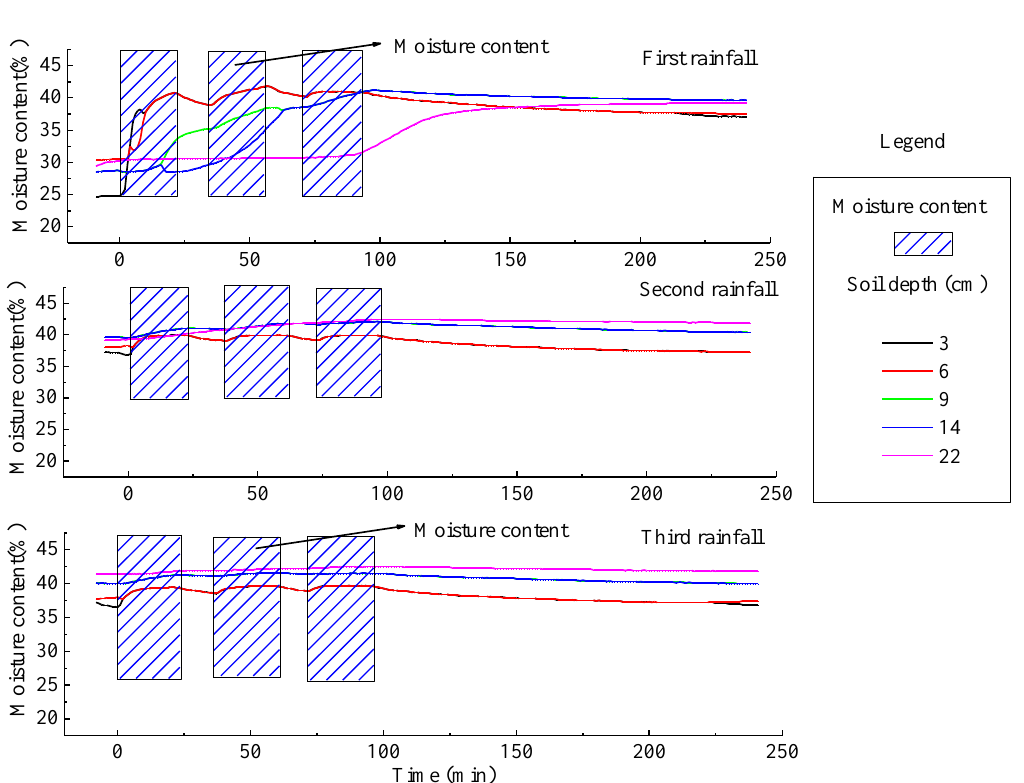
Figure 6. Dynamic change process of soil water content of the loess slope at a rainfall density of 1.0 mm/min.